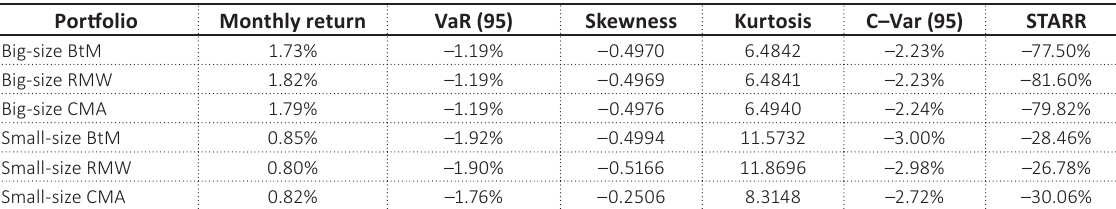
Table 5. Summary